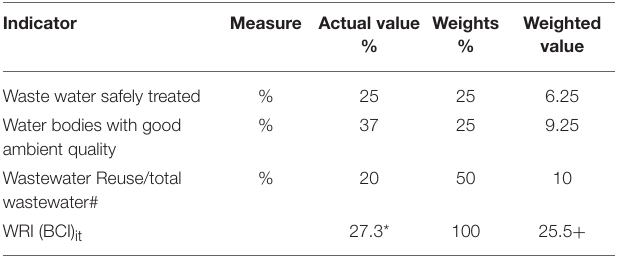
TABLE 2 | Biophysical component index of wastewater reuse effectiveness index developed based on data for India (WRI-BCI).